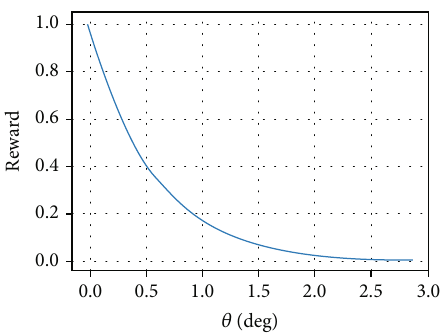
Figure 4: The Gaussian reward